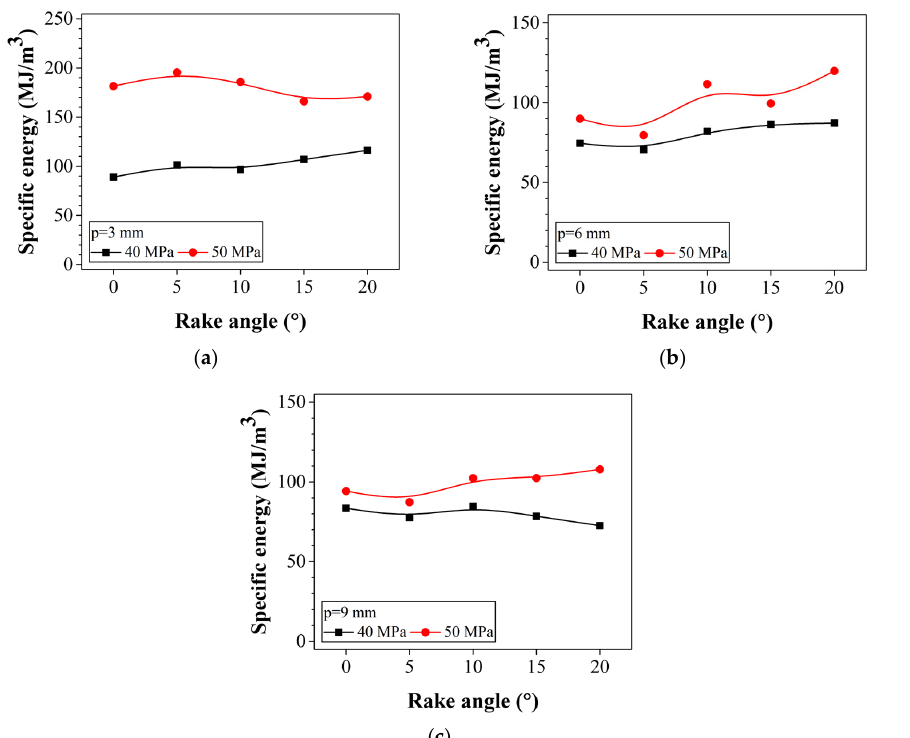
Figure 19. Relationship between the specific energy and rake angle at depths ( p ) of: ( a ) 3 mm, ( b ) 6 mm, and ( c ) 9 mm.